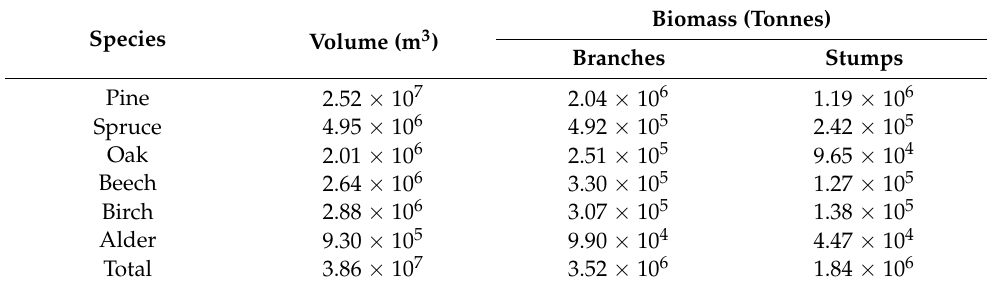
Table 3. The biomass of branches and stumps of trees felled annually in Polish State Forests.